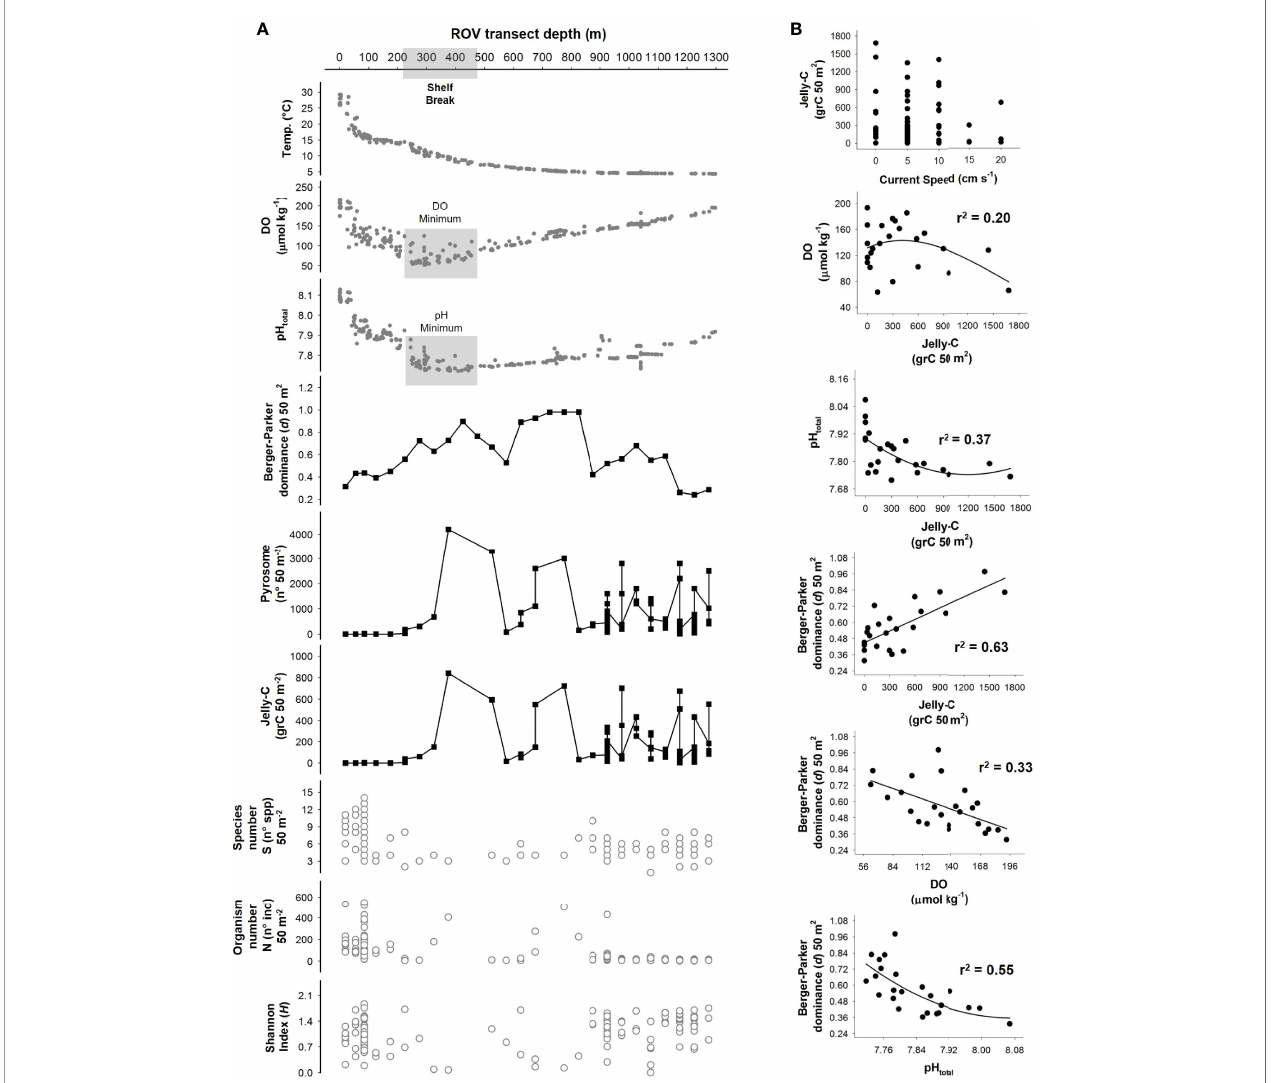
FIGURE 4 | Fine-scale vertical comparison of abiotic and biotic variables along the bathymetric gradient as well as correlations of main explanatory variables. (A) Main environmental parameters compared with biological data on a detailed 50-m 2 re-analysis of the remotely operated vehicle (ROV) transect-based data. This visualization helps to link the megafaunal aggregations, triggering dominance events to environmental context with respect to depth. (B) Individual correlations between the main variables driving the system were assessed according to multiple regression and principal component analysis (PCA). All data are plotted in raw format (no transformation) using 50-m 2 -sized sampling